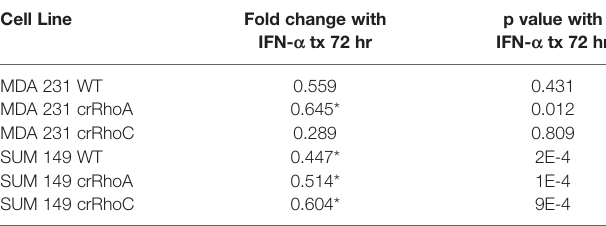
TABLE 2 | RhoC knockout modulates IFN- a -driven inhibition of cell invasion. Cell Line